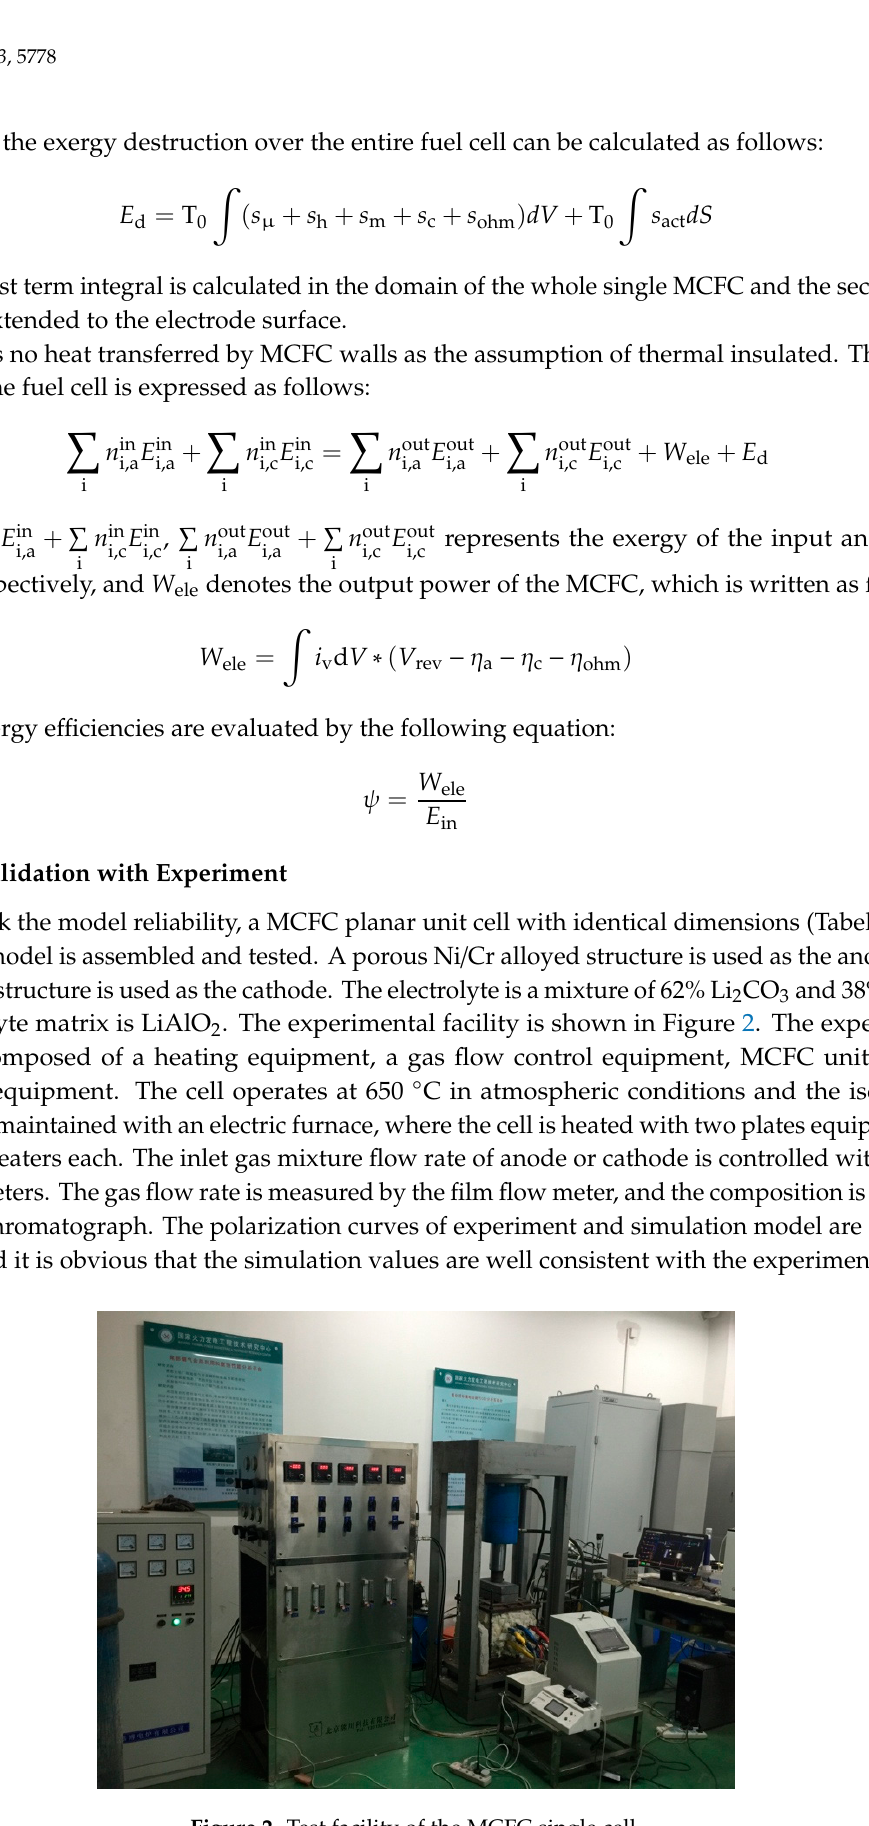
Figure 2. Test facility of the MCFC single cell.